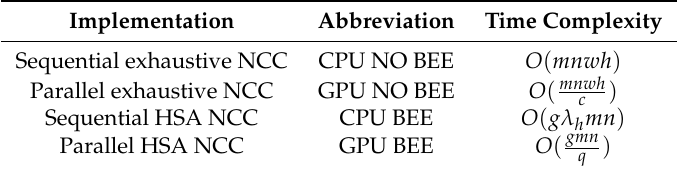
Table 2. Time Complexity of different implementations to be